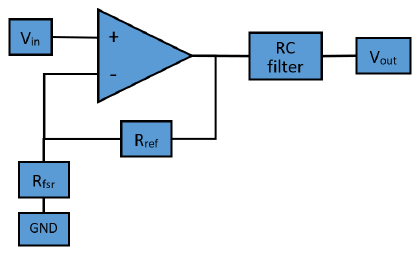
Figure 2: FSR amplification circuitry.